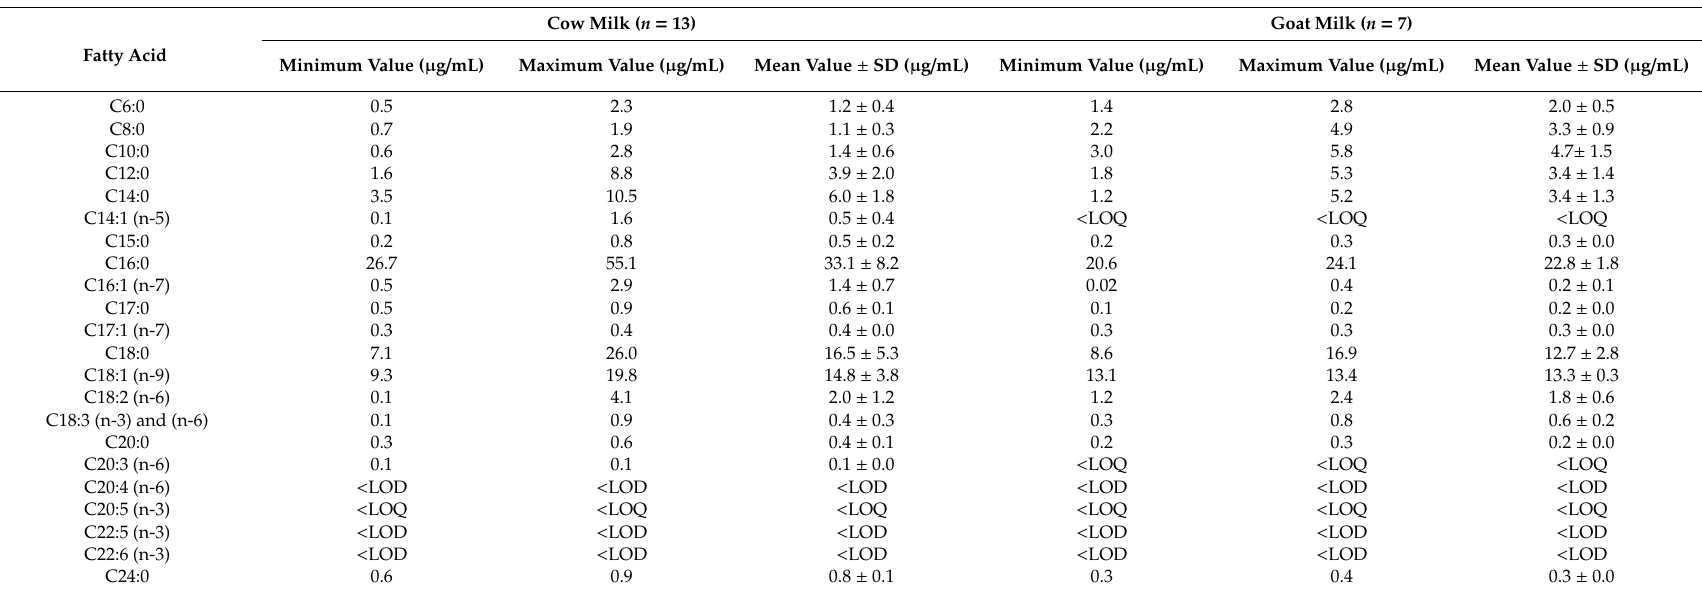
Table 4. Contents of free fatty acids in cow milk and goat milk samples ( µ g / mL fresh